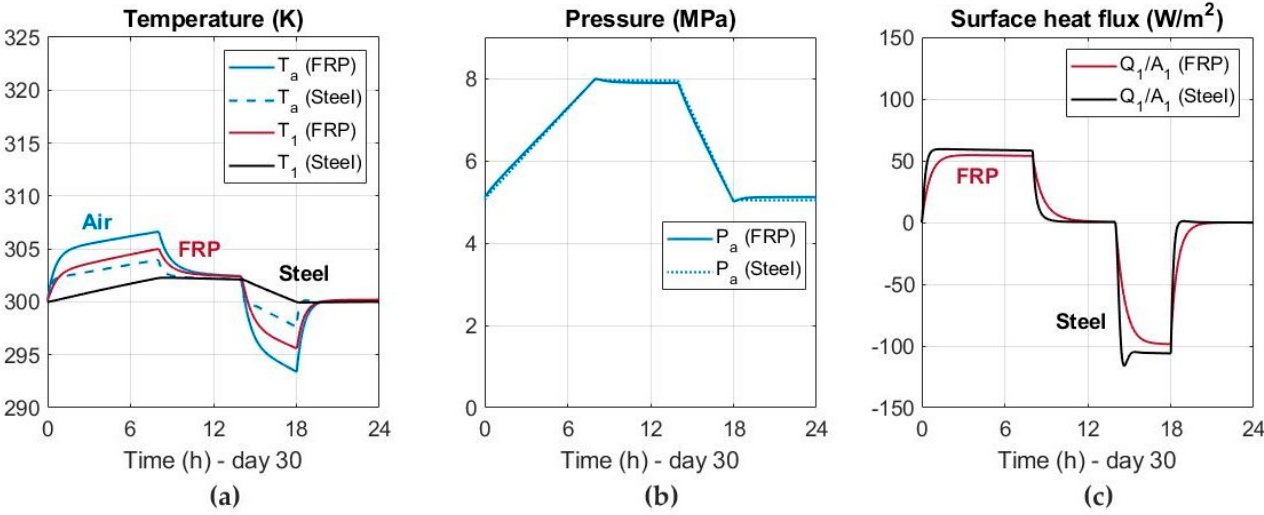
Figure 8. Comparative analysis between FRP and steel in the 30th cycle. ( a ) Temperature of air, FRP and steel; ( b ) Air pressure; ( c ) Surface heat flux of FRP and steel.